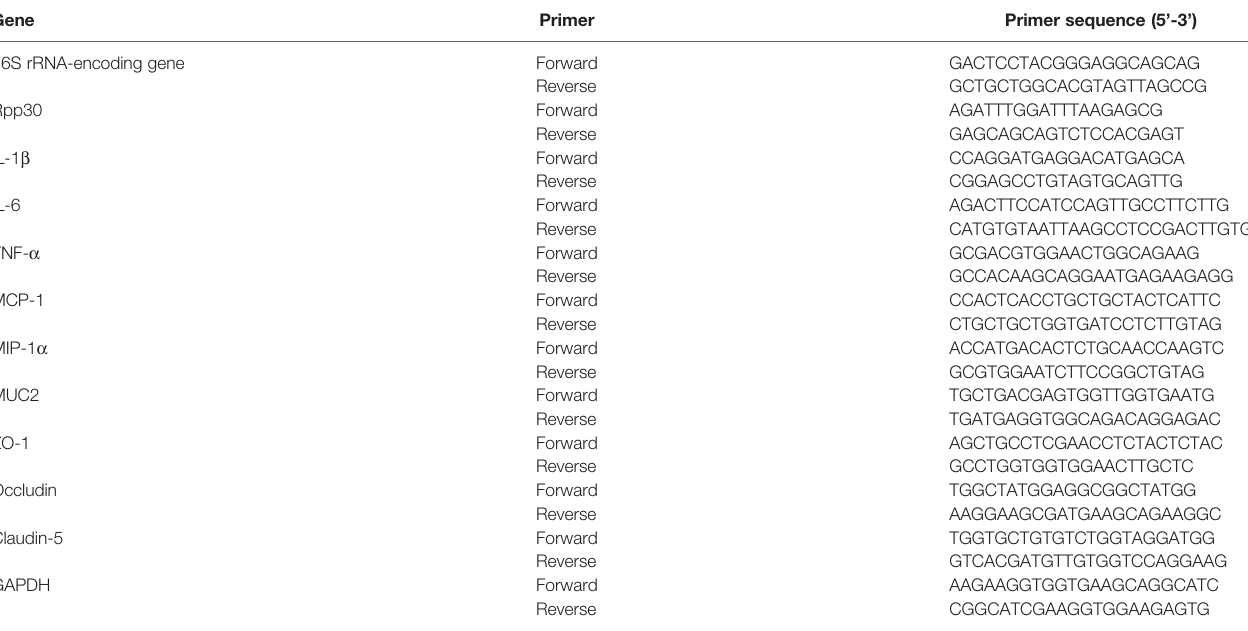
TABLE 1 | Sequences of RT-qPCR primers.